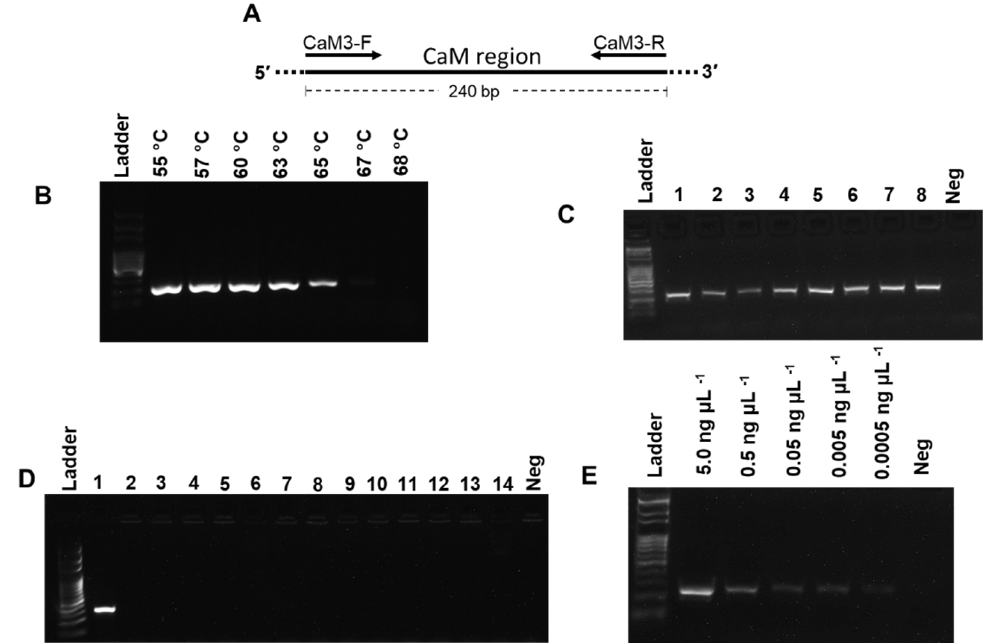
Figure 2. CaM PCR primer design and optimization. ( A ) New primer design for CaM3 PCR primers amplifying Clarireedia spp. ( B ) Temperature optimization of CaM3 primers from 55–68 °C using